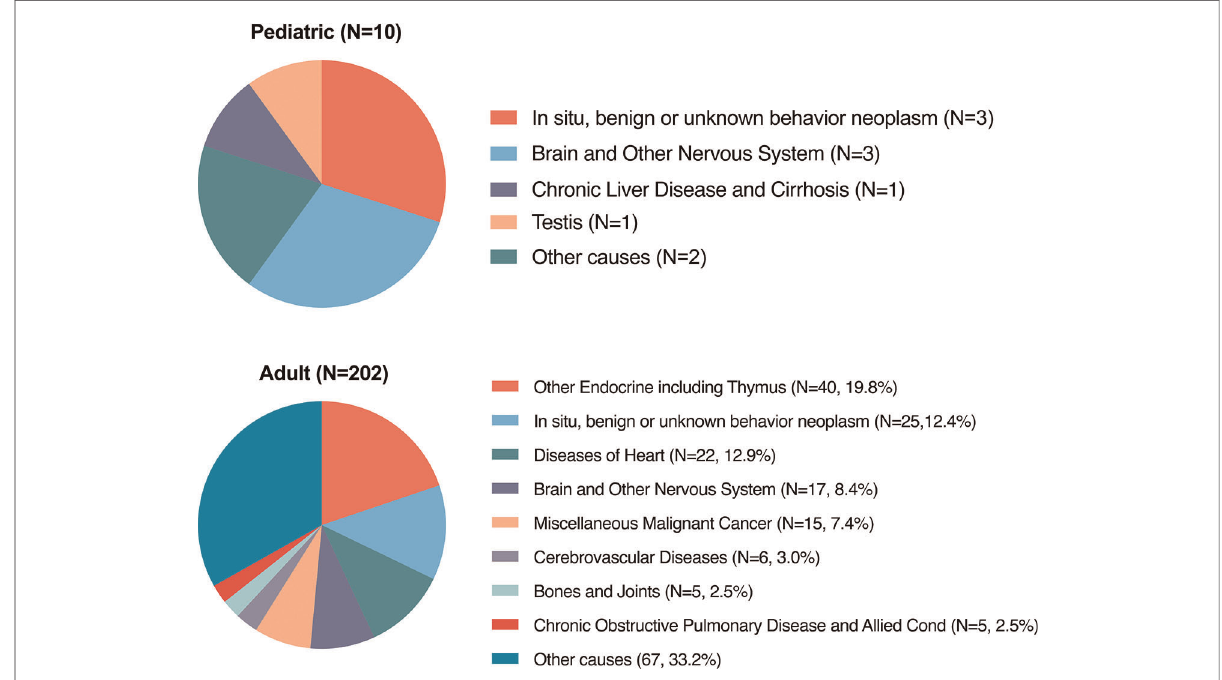
FIGURE 5 Causes of death among pediatric and adult patients with primary malignant pituitary tumor from the SEER 18 registries custom